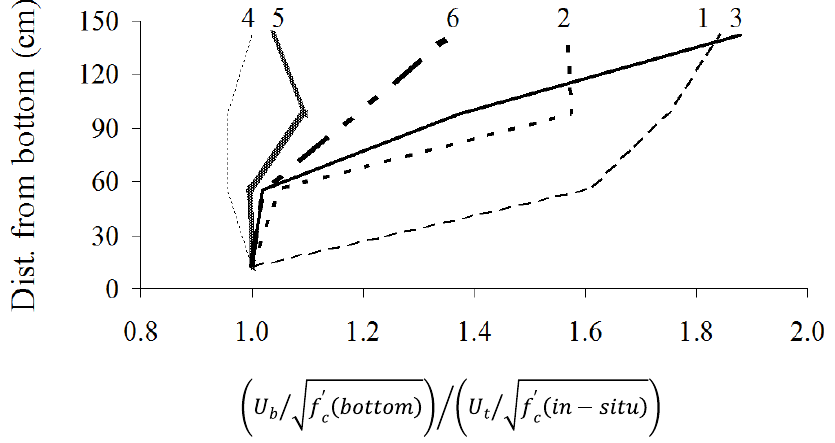
Figure 12. Variation of modification factor of prestressing strands along wall